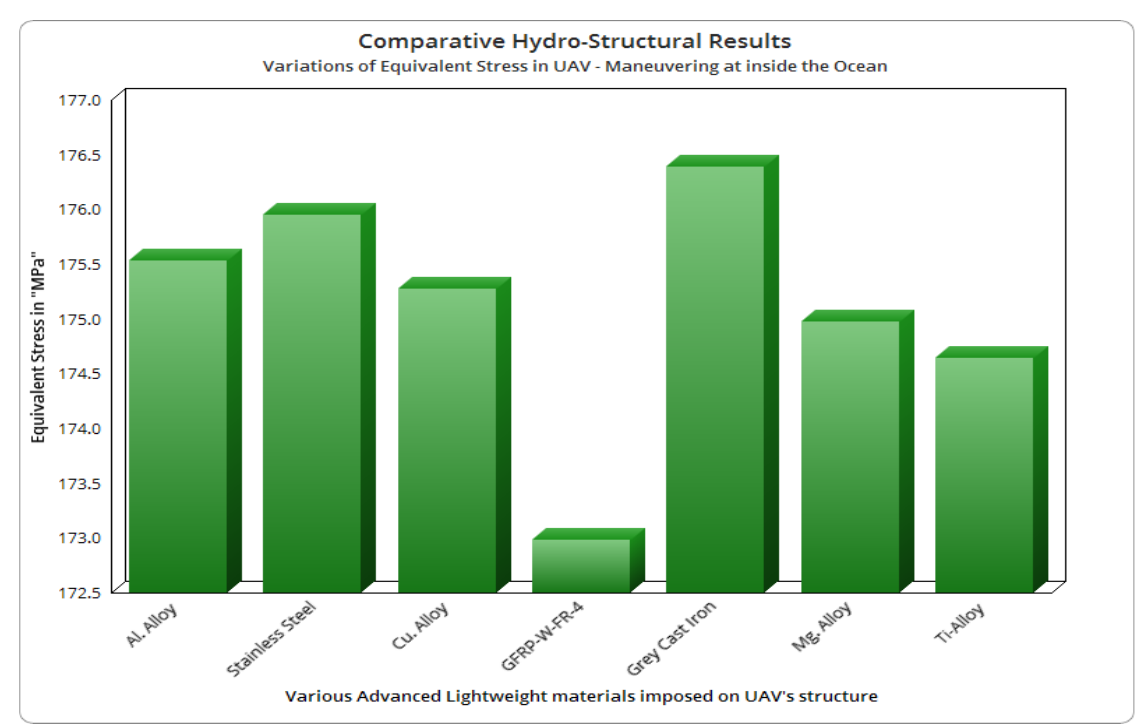
Figure 40. Comparative equivalent stress variations for various lightweight materials.